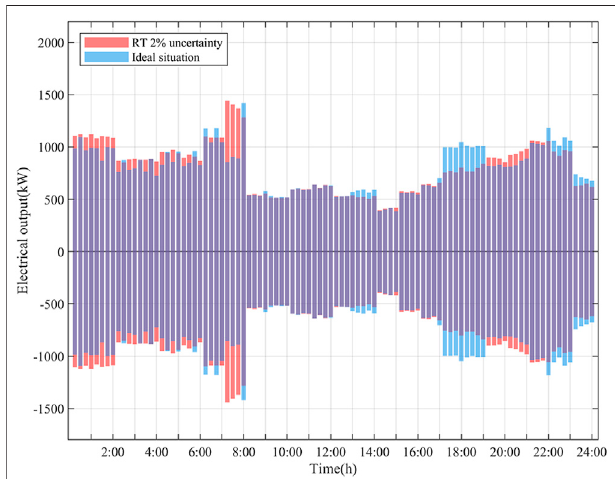
FIGURE 11 | Comparison of ideal and RT electric output.